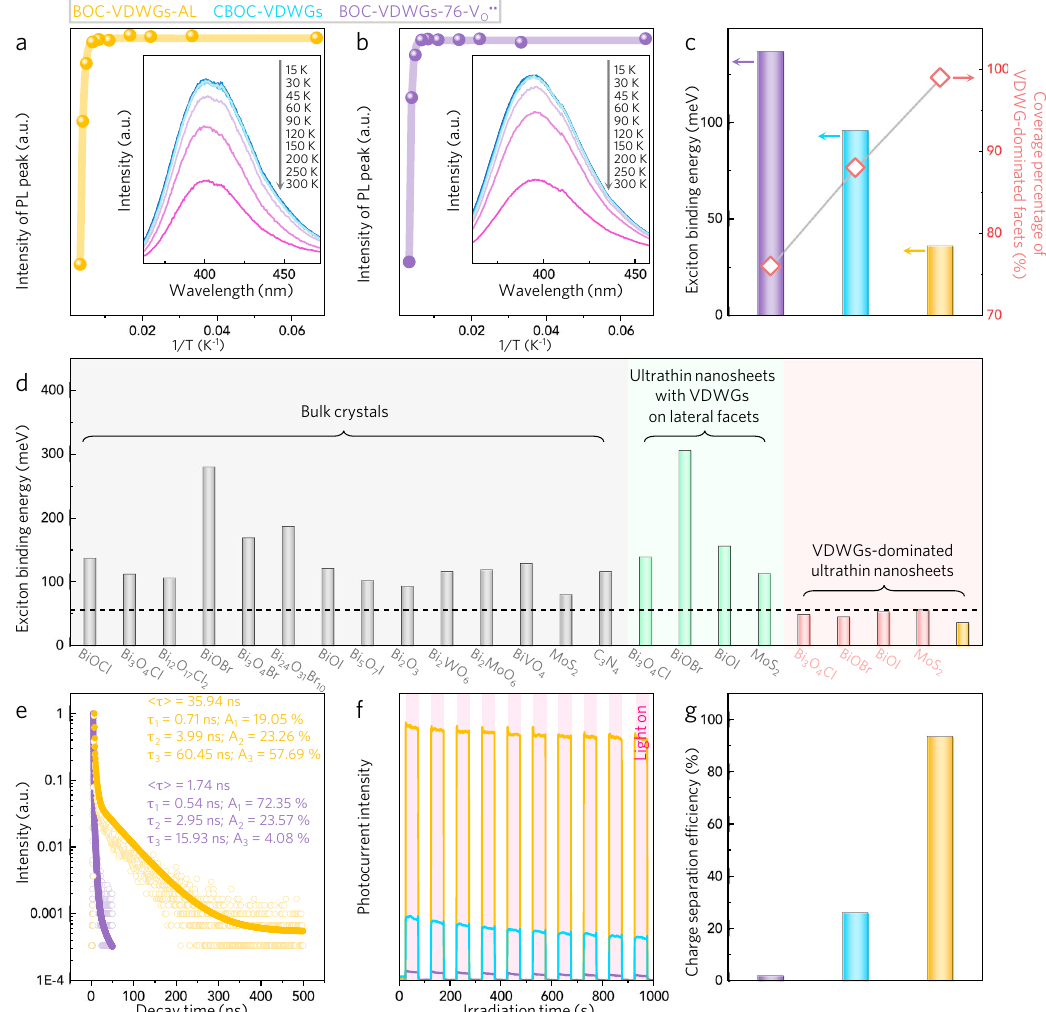
Fig. 3 Promoting effect of VDWGs on exciton binding energy and, consequently, on electron – hole separation. a , b PL of BOC-VDWGs-AL ( a ) and BOC- VDWGs-76 ( b ) as a function of operation temperature. c Comparisons of E b and VDWG coverage percentage of BOC-VDWGs-AL, CBOC-VDWGs, and BOC-VDWGs-76. d Comparisons of E b of BOC-VDWGs-AL and some representative layered photocatalysts. e Time-resolved PL of BOC-VDWGs-AL and BOC-VDWGs-76. f , g Transient photocurrent responses ( f ) and bulk charge separation ef fi ciencies ( g ) of BOC-VDWGs-AL, CBOC-VDWGs, and BOC-